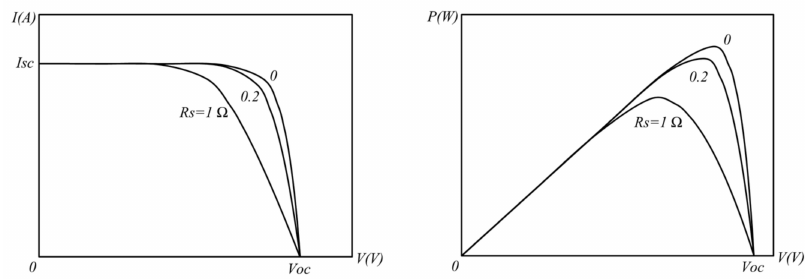
Figure 4. Influence of the series resistance on the solar cell output properties.